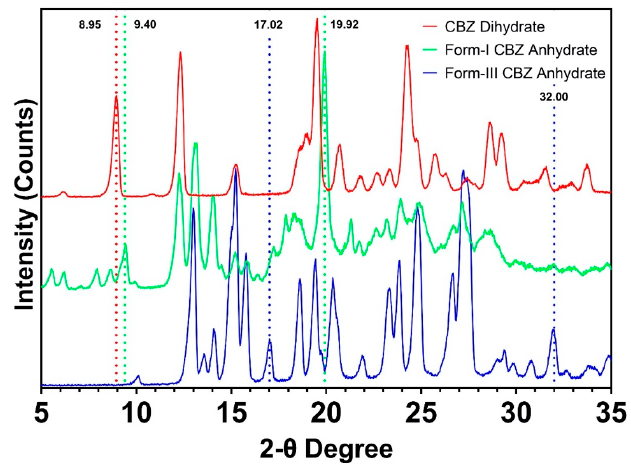
Figure 2. XRPD patterns of CBZ dihydrate (red), form-I CBZ anhydrate (green), and form-III CBZ anhydrate (blue).